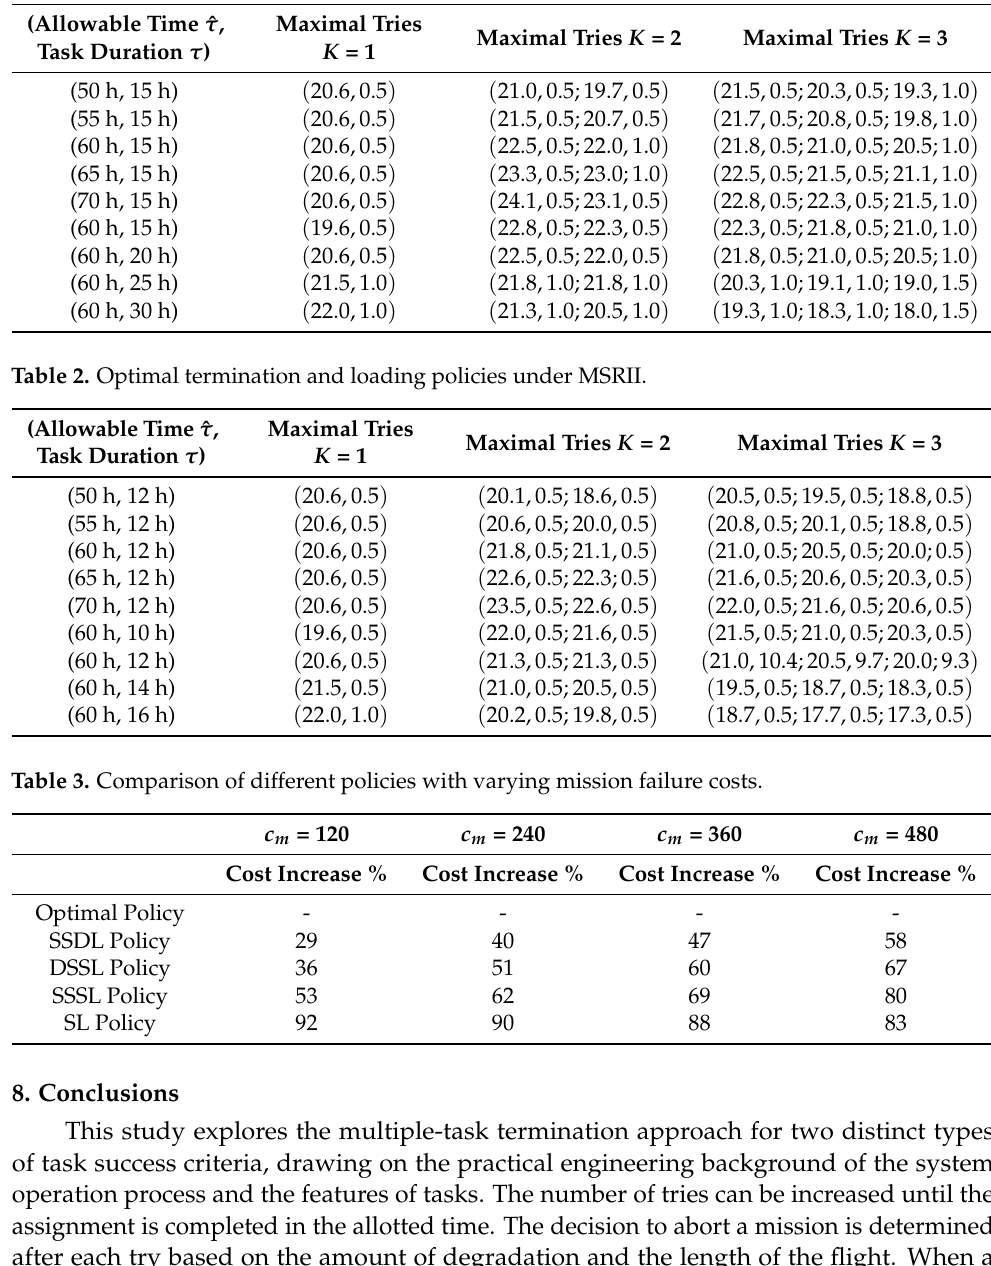
Table 1. Optimal termination thresholds under MSRI.